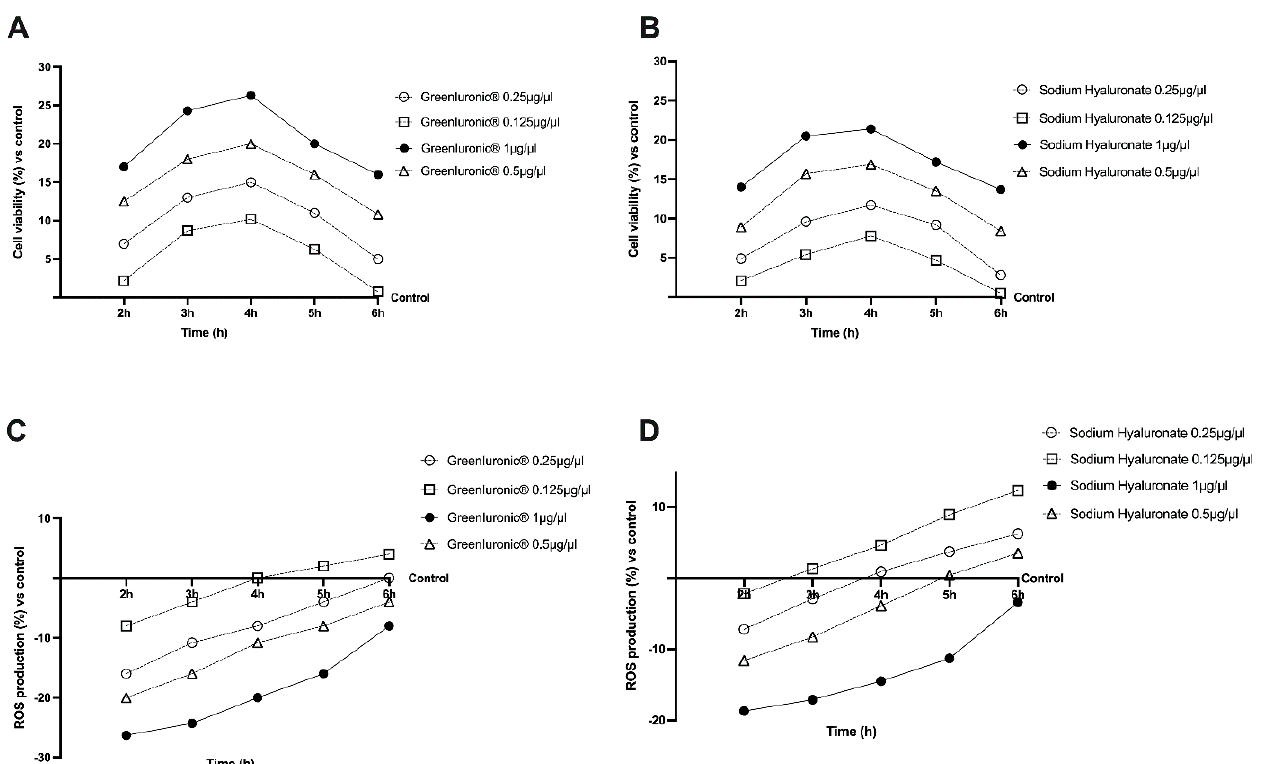
Figure 3. Cell viability and ROS production on CaCo-2 cells. In panel ( A , B ) dose–response study on cell viability measured by MTT test of both GreenIuronic ® and Sodium Hyaluronate from 2 to 6 h. In panel ( C , D ) ROS production of both GreenIuronic ® and Sodium Hyaluronate measured by reduction in cytochrome C from 2 to 6 h. Data are mean ± SD of five independent experiments performed in triplicates vs. control values (0% line).